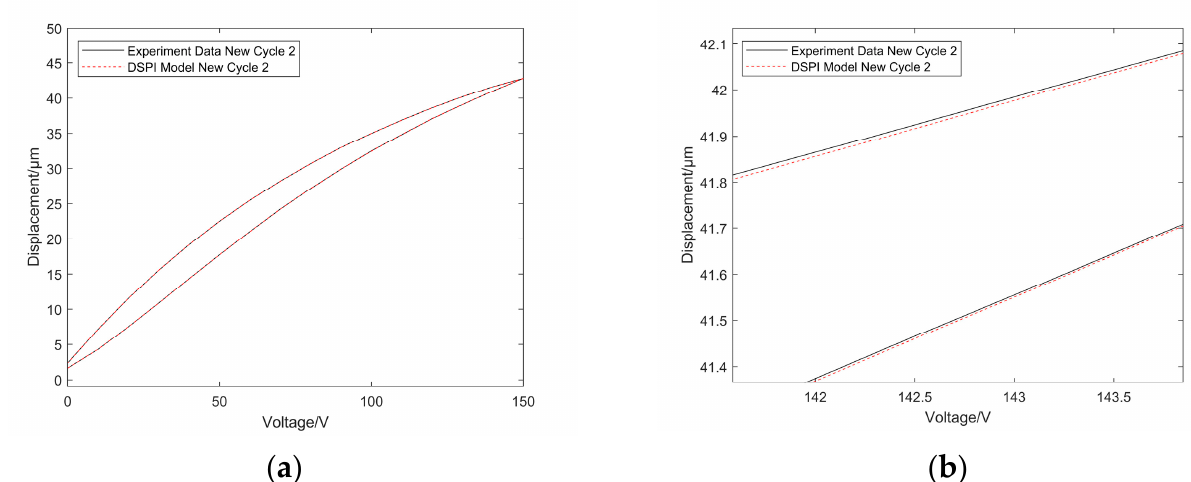
( b ) Figure 17. DSPI model: ( a ) modeling of the hysteresis characteristics after merging the first and new second cycle data; ( b ) local enlargement. 5.2. Results of the DSPI Inverse Model Figures 18a–c show the corresponding DSPI inverse models of Figures 15a–17a, re- spectively. The compensation voltage obtained from the DSPI inverse model is used for feedforward control. The experimental verification of the feedforward control compensa- tion results is discussed and analyzed in the next Section 5.3.